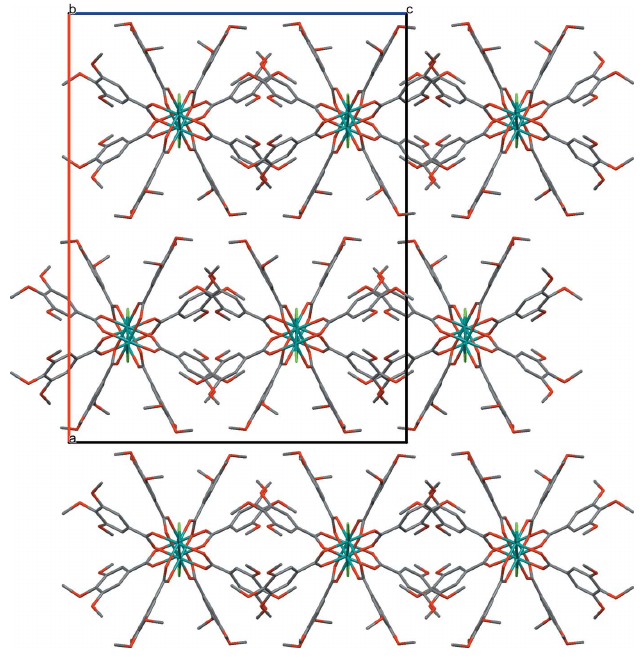
Figure 2 Zigzag chain of [Ru 2 Cl{ (cid:2) -O 2 CC 6 H 2 -3,4,5-(OMe) 3 } 4 ] n . Hydrogen atoms have been omitted for